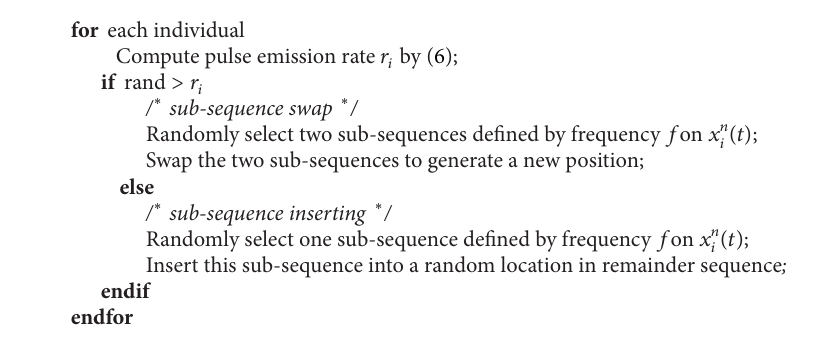
Algorithm 3: The pseudocode of pulse emission rate local